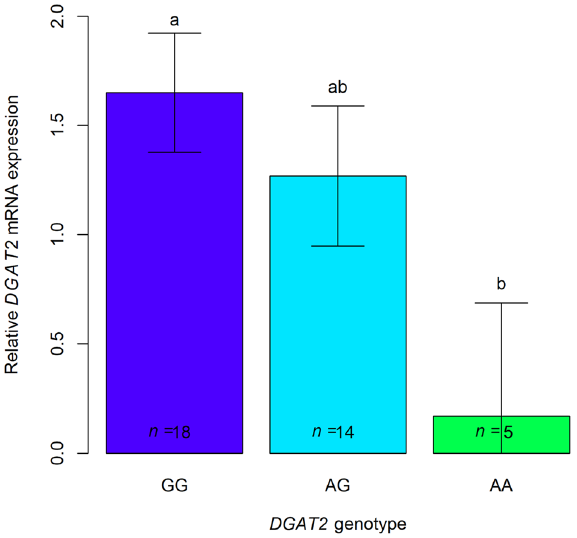
Figure 3. Relative expression of DGAT2 across ss7315407085 genotypes. Numbers in boxes indicate the number of pigs used per genotype ( n ). Error bars represent standard errors. Columns lacking a common letter differ (P < 0.05).